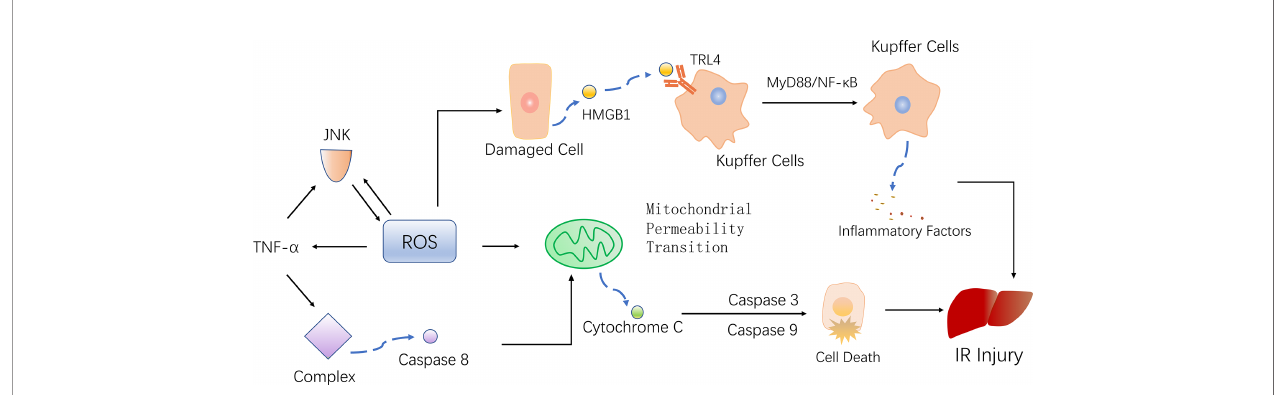
FIGURE 2 | ROS mediates in fl ammation, mitochondrial damage, and cell death, ultimately promoting liver damage. KCs recognize HMGB1, promote the in fl ammatory response through the TRL4-MyD88-NF- k B pathway. At the same time, TNF- a activated by ROS, phosphorylating JNK and further producing ROS. Activated TNF- a also form complexes that activate caspase 8, leading to mitochondrial permeability transition (MTP) and fi